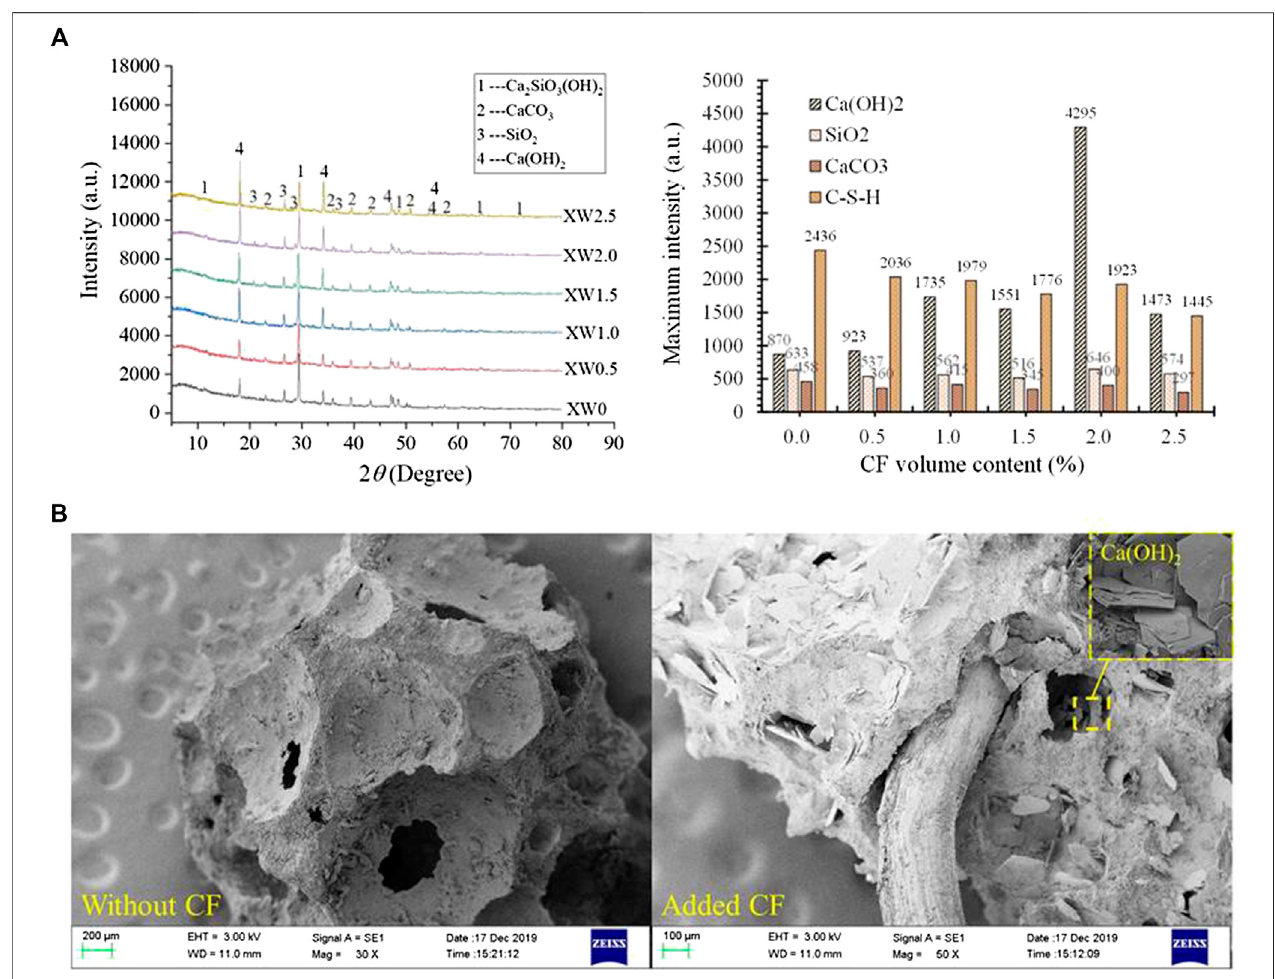
FIGURE 9 | Microstructure (A) XRD spectrum (B) SEM result.